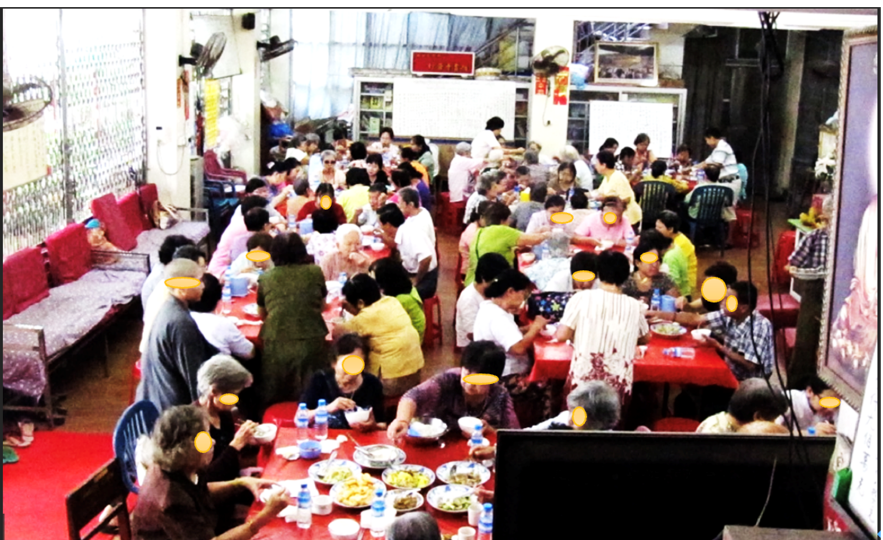
Figure 9. Sino-Burmese laypeople eating together after a Buddhist ceremony on the 1st day of the lunar month (Source: